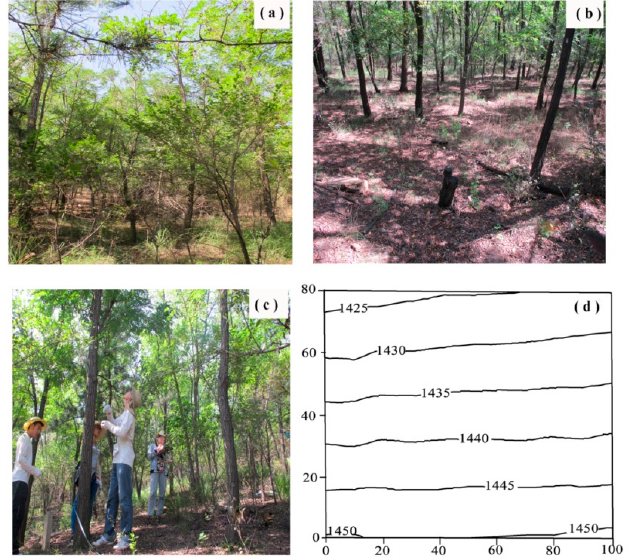
Figure 1. ( a – c ) Photos and ( d ) topography of the plot in Pinshuo opencast coal mine, China. Axis scale is in meters. The black lines in ( d ) was the contours (marked with elevation values, m ASL).